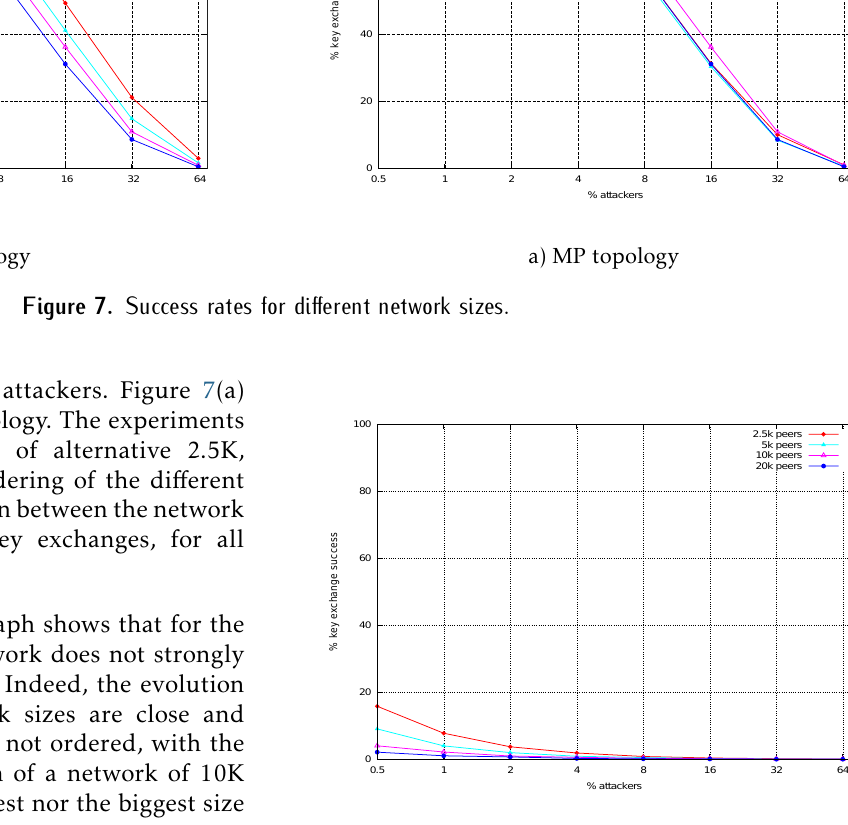
Figure 8. Success rates for different ring topology